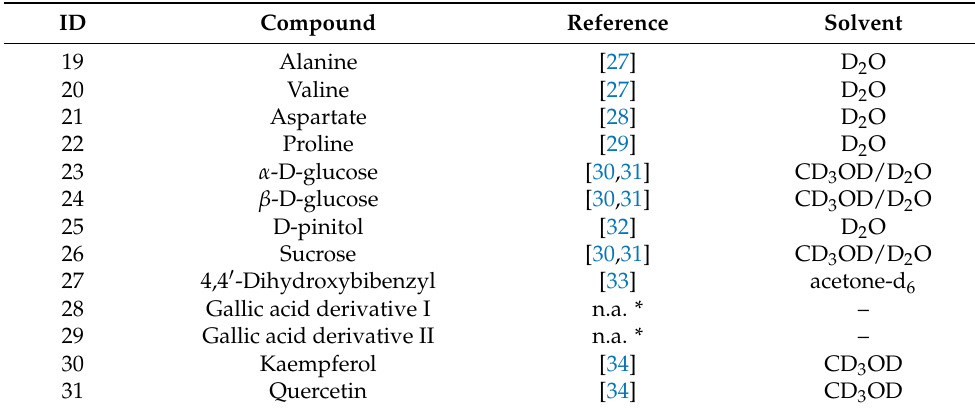
Figure 2. Structure of compounds identified by NMR in the hydroalcoholic leaf extract of Bauhinia ungulata . Table 2. References reporting previous NMR data of the metabolites identified in the hydroalcoholic leaf extract of Bauhinia ungulata